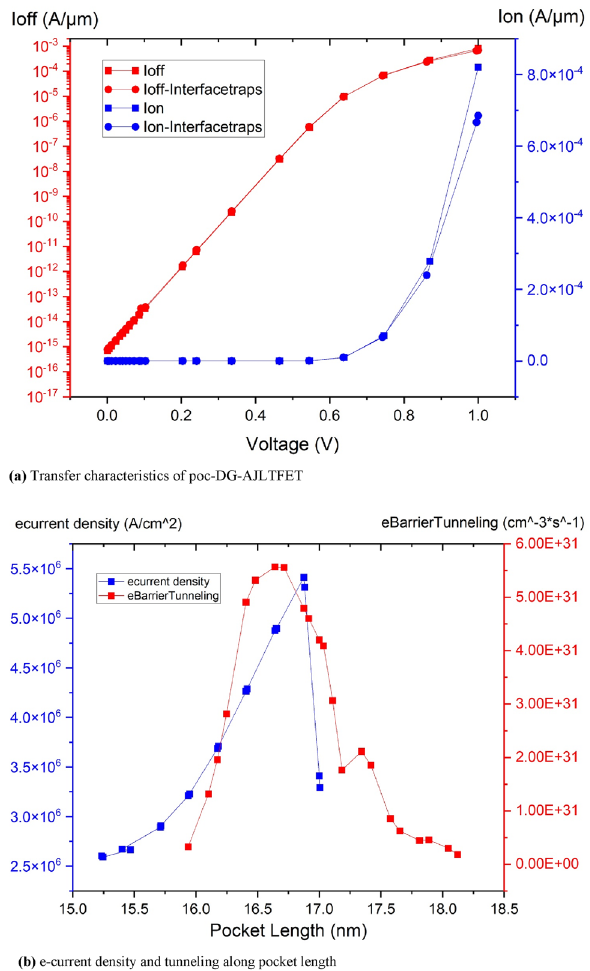
Figure 2. ( a ) Transfer characteristics of poc-DG-AJLTFET. ( b ) e-current density and tunneling along pocket